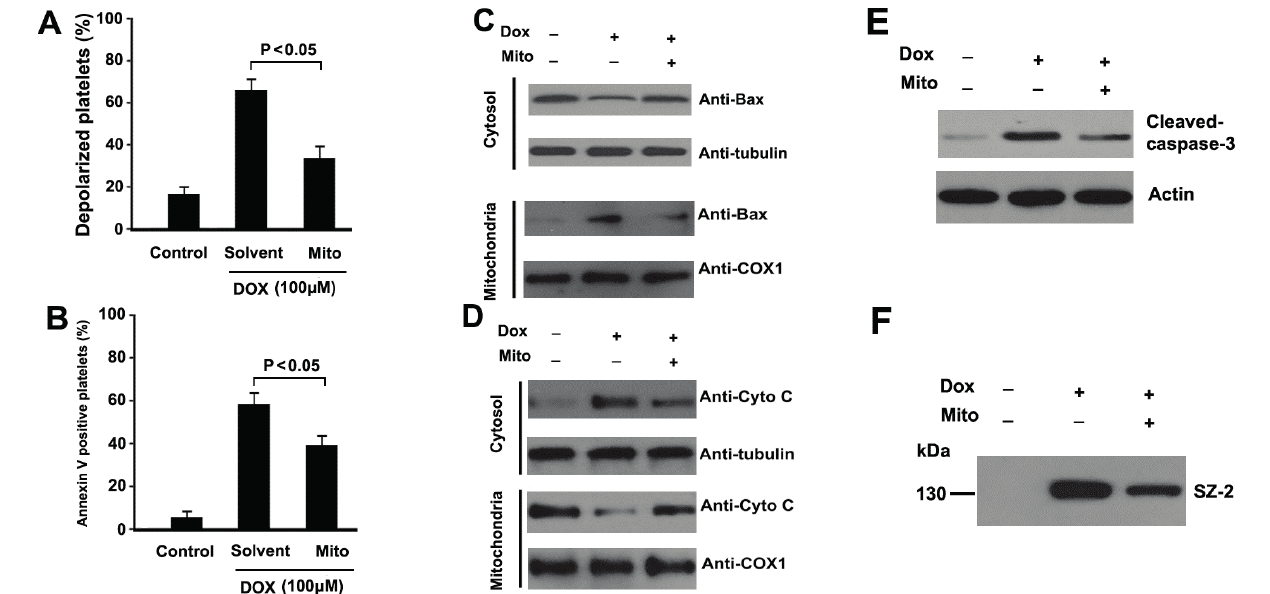
Figure 6. Mitochondria-targeted ROS scavenger attenuated DOX- induced platelet apoptosis. ( A , B ) Platelets were pre-incubated with Mito-TEMPO or solvent, and then incubated with DOX; Treated platelets were incubated with TMRE ( A ), or annexin V-FITC ( B ), and analyzed by flow cytometry. ΔΨ m depolarization and PS exposure was quantified as the percentage of depolarized platelets. Means ± SEM from three independent experiments are shown; ( C , D ) Platelets were pre-incubated with Mito-TEMPO or solvent, and then incubated with DOX. Treated platelets were lysed, and cytosol and mitochondrial fractions were isolated and analyzed by Western blot with anti-Bax ( C ), and anti-cytochrome C antibodies ( D ); Representative results of three independent experiments are presented; ( E ) Platelets were pro-incubated with Mito-TEMPO or solvent, and then incubated with DOX. Treated platelets were lysed and analyzed by Western blot with anti-caspase-3 antibody. Actin levels were assayed to demonstrate equal protein loading. Representative results of three independent experiments are presented; ( F ) Platelets were pre-incubated with Mito-TEMPO or solvent, and then incubated with DOX. Treated platelets were centrifuged, and supernatants were analyzed by Western blot with SZ-2. Representative results of three independent experiments are presented. Mito-TEMPO is labeled as